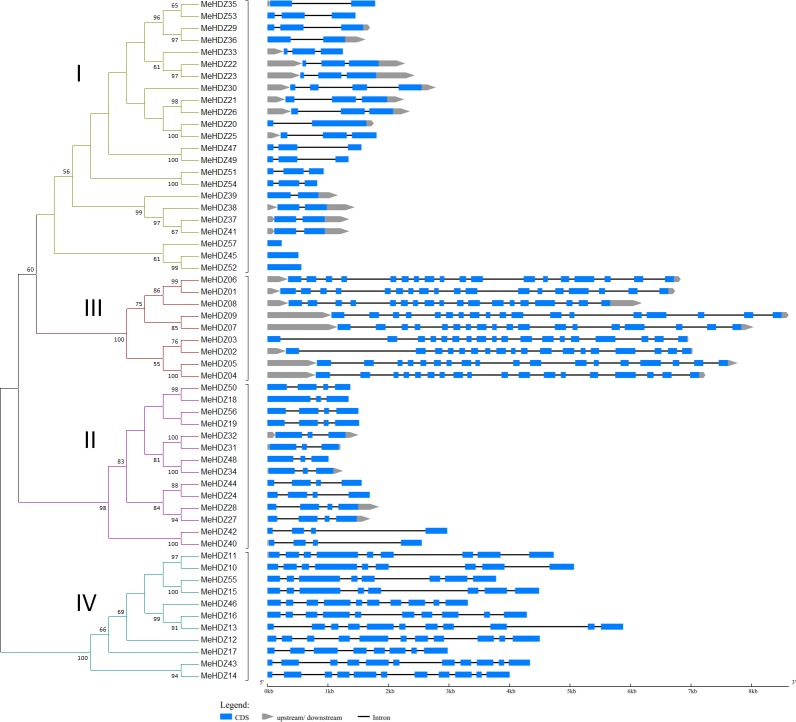
Exon-intron structure of 57 MeHDZ genes in cassava.The phylogenetic tree was constructed by Maximum-Likelihood method with 1000 bootstrap replicates. The MeHDZ genes were clustered into four groups, I to IV. Exon-intron analysis was performed using GSDS (http://gsds.cbi.pku.edu.cn/). Length of exons and introns of each MeHDZ gene was displayed proportionally. Upstream was defined as the sequences before the transcription start site ‘ATG’, while downstream was defined as the sequences after the stop codon (e.g., ‘TAA’).